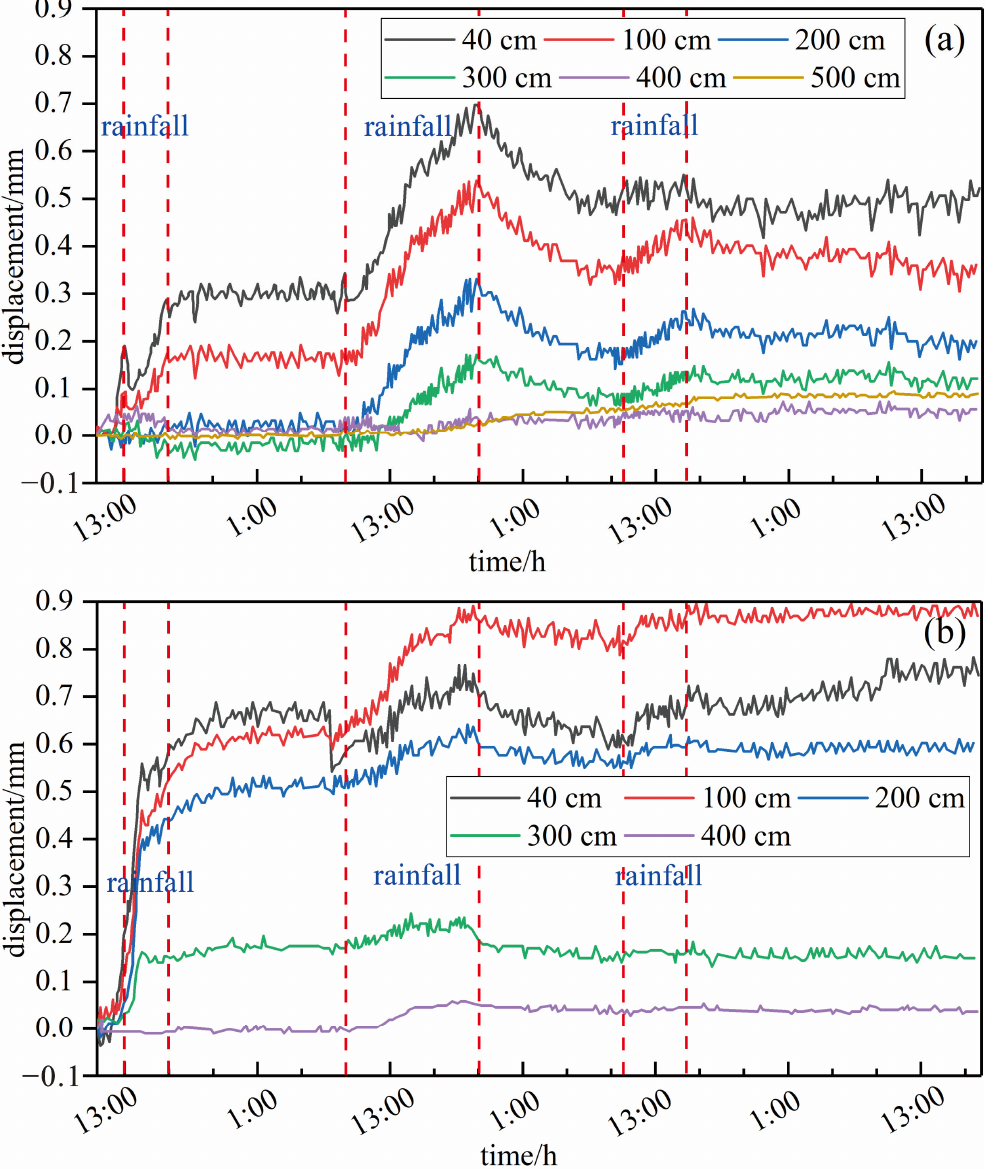
Figure 10. Displacement curves of different parts of the slope under the first condition: ( a ) No. 1 borehole equipped with inclinometers, ( b ) No. 2 borehole equipped with